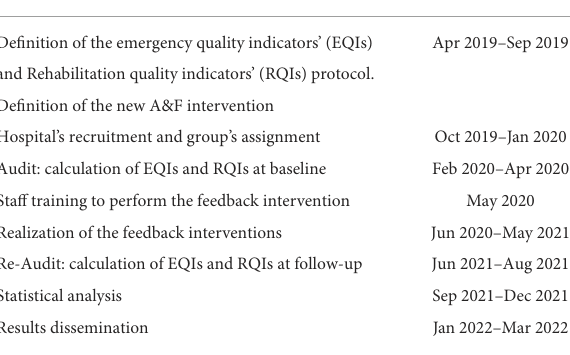
TABLE 2 Timelines of the EASY-NET WP7